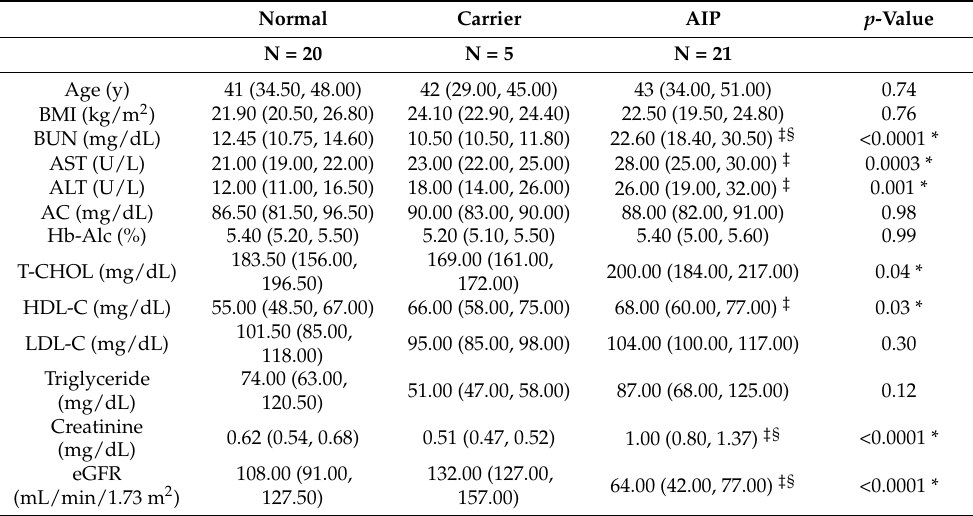
Table 1. Baseline characteristics of normal, asymptomatic carriers, and AIP